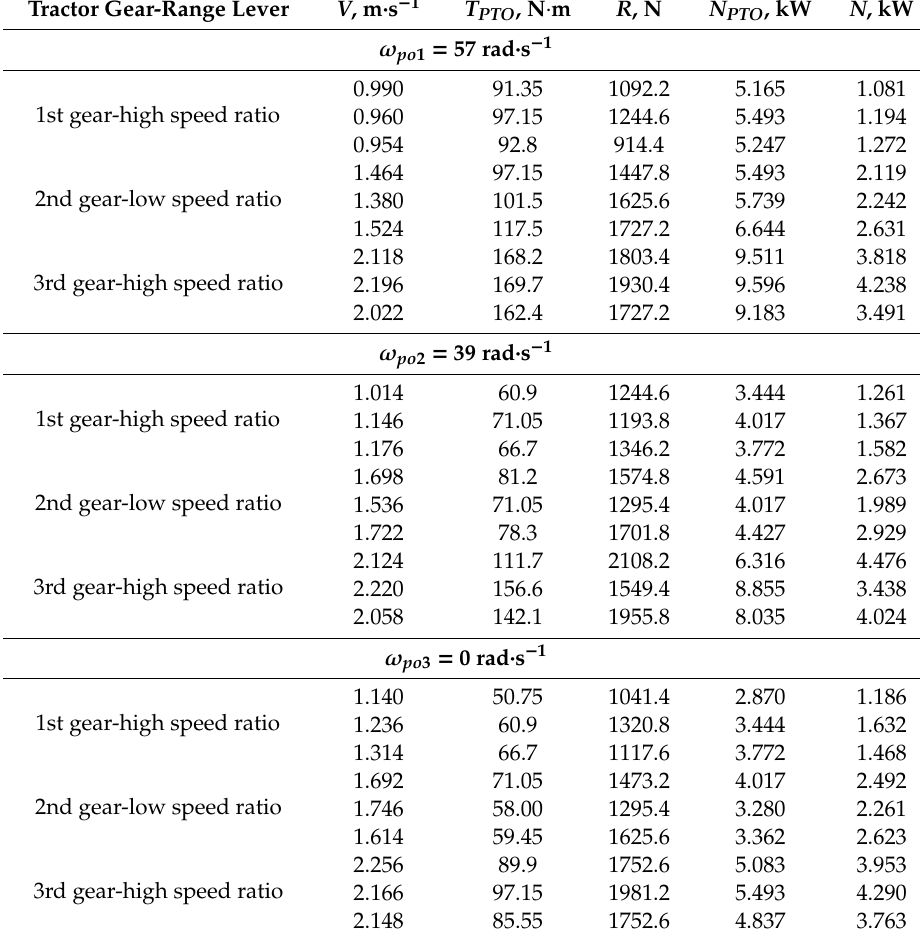
Table 1. Beet top harvester obtained experimental data.